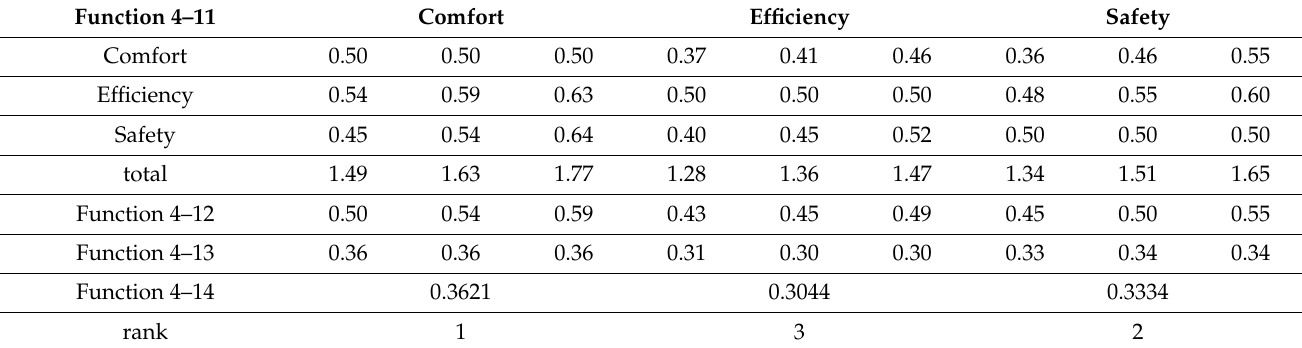
Table A15. Hotels’ weights of attributes of the functional value.